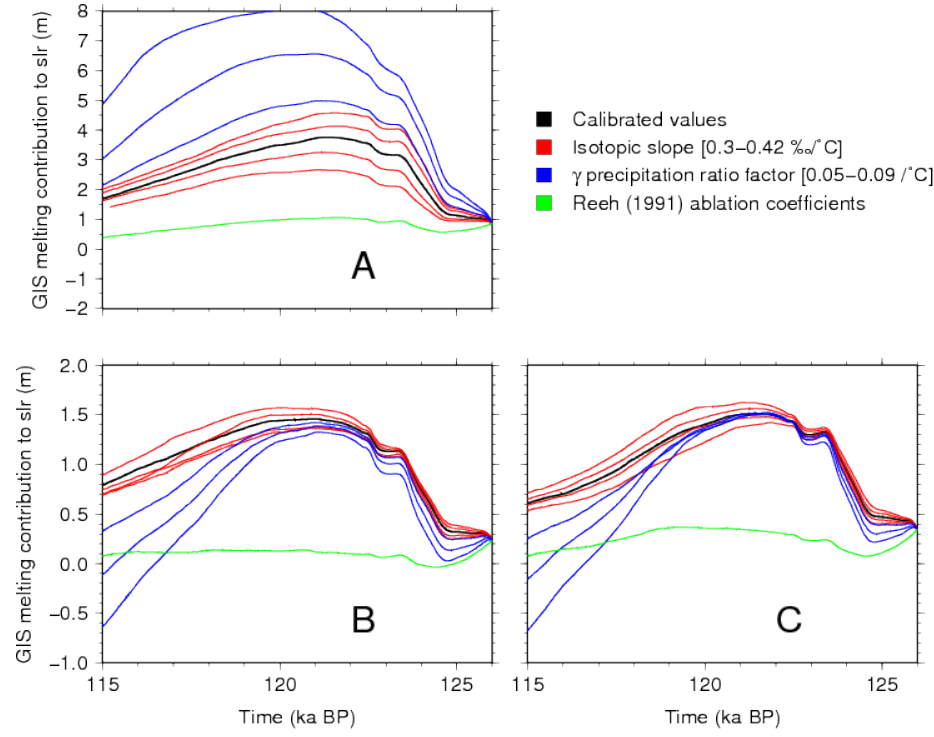
Fig. 8. Sensitivity of simulated GIS melting contribution to sea level rise during the LIG period to the following: isotopic slope which governs prescribed temperature anomaly amplitude, ranging from 0.30‰ ◦ C − 1 (lower than calibrated value and corresponding to higher values of temperature anomalies) to 0.42‰ ◦ C − 1 (higher than calibrated value and corresponding to lower values of temperature anomalies); precipitation ratio γ ranging from 0.05 ◦ C to 0.09 ◦ C, values lower than the calibrated ones, corresponding more to what has been used in previous studies; the use of Reeh (1991) ablation coefficients rather than Tarasov and Peltier (2002) ones. (A) no-anomaly experiment; (B) CNRM anomaly; (C) IPSL anomaly. The scales of volume variation are changed from (A) to (B) and (C) . The two experiments with GCM snapshots seem to be relatively robust to the choice of parameters. The experiment presenting the greatest retreat is the most sensitive one. Note that we cannot produce a realistic present-day ice sheet with the original Reeh (1991) ablation coefficients, as already mentioned in Ritz et al. (1997) and Greve et al.